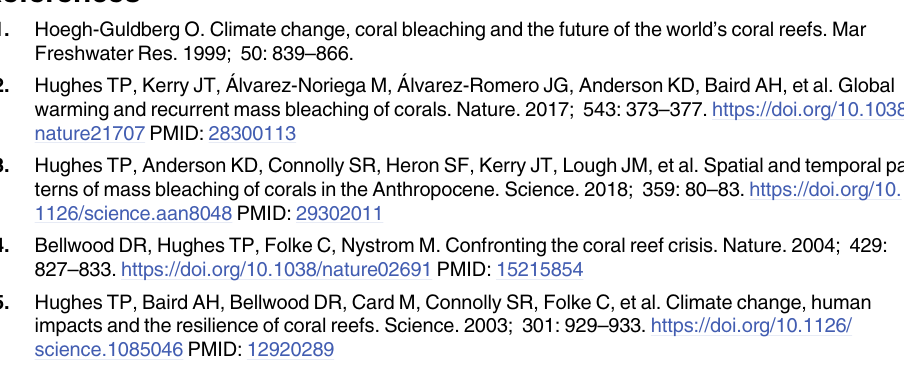
S3 Fig. Relationship between symbionts ( Symbiodinium density x10 6 / cm 2 ) and photosyn- thetic efficiency (F /F of P. damicornis colonies at three different time periods in aquaria V M experiment. Photosynthetic efficiency (F /F ) of P . damicornis colonies was recorded during: V M Acclimation (day 5), Stress (day 37) and Recovery (Day 66), in aquaria experiment. Linear regression analysis (Pearson’s correlation r 2 = 0.5468, F = 12.07, p = 0.0060, y = 0.2266x + 1,10 0.378) suggests direct correlation between Symbiodinium and photosynthetic efficiency in experimental